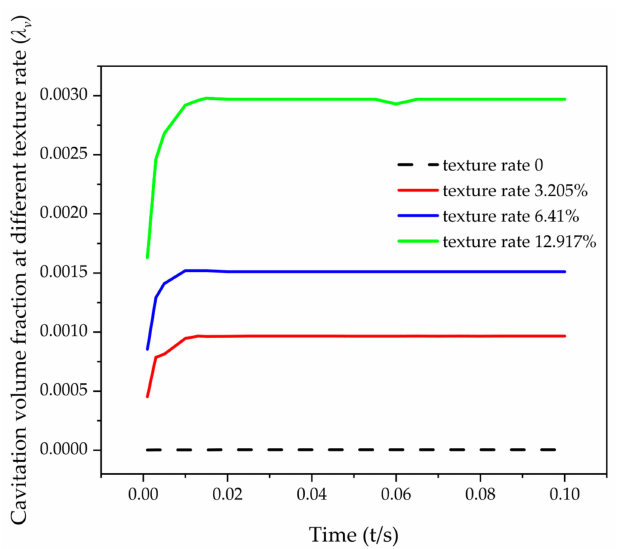
Figure 17. Cavitation volume fraction at different texture